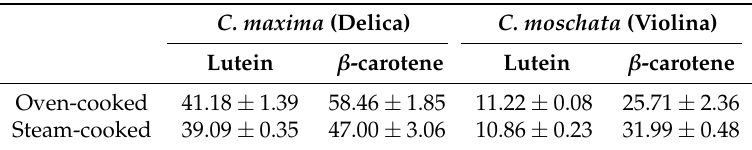
Table 3. Quantification of lutein and β -carotene in cooked pumpkin samples. Data are reported as µ